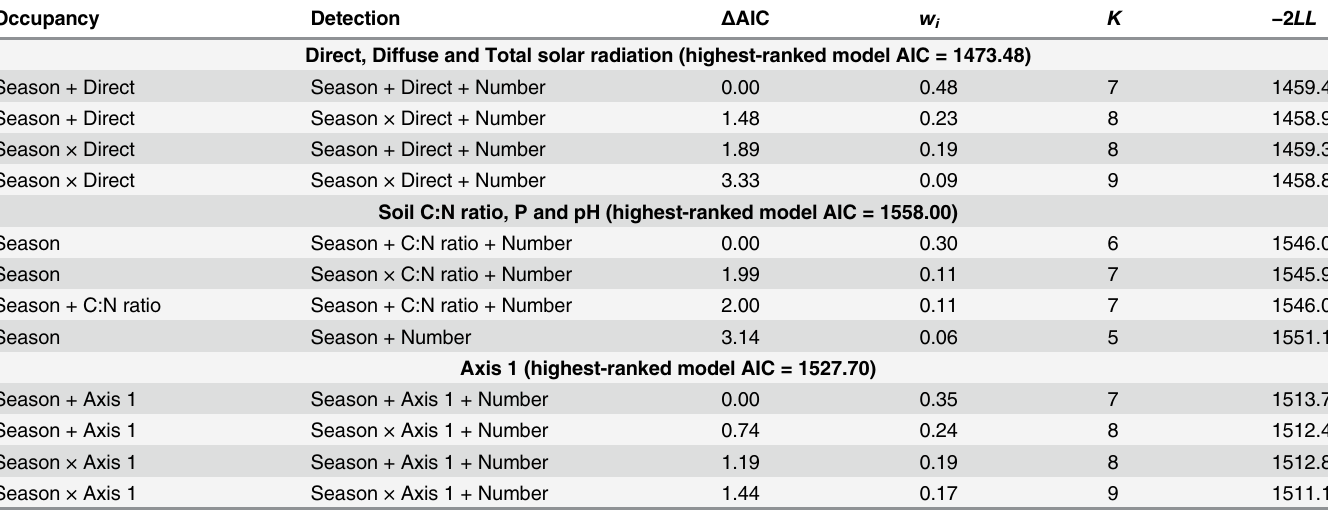
Table 2. Multiseason occupancy models for rusa deer camera trap data collected in winter and summer.